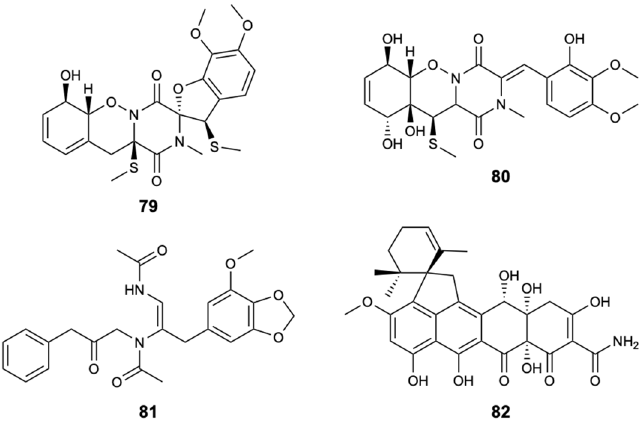
Figure 21. Structures of dithiodiketopiperazine derivatives ( 79 – 82 ).